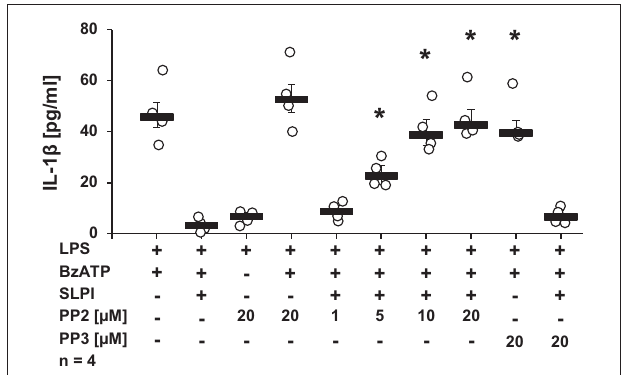
FIGURE 8 | SLPI signals via Src kinase. Human monocytic U937 cells were primed with LPS (1 µ g/ml, for 5h) and further stimulated with 2 ′ (3 ′ )-O-(4-benzoylbenzoyl)adenosine 5 ′ -triphosphate triethylammonium salt (BzATP; 100mM) for 30min. SLPI was applied in the presence of different concentrations of the Src kinase inhibitor (PP2) or its inactive analogue (PP3). The concentration of IL-1 β in cell culture supernatants was measured by ELISA. PP2 suppressed the SLPI-mediated inhibition. * p ≤ 0.05 significantly different compared to cells stimulated with LPS, BzATP, and SLPI. Experimental groups were compared by Kruskal-Wallis test followed by Mann-Whitney rank sum